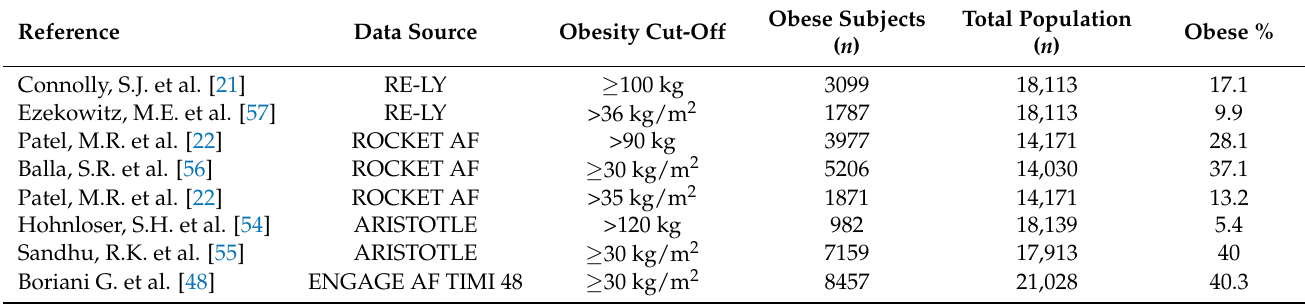
Legend. DOACs: direct oral anticoagulants. RE-LY indicates Randomized Evaluation of Long-Term Anticoagulation Therapy; ROCKET AF, Rivaroxaban Once Daily Oral Direct Factor Xa Inhibition Compared with Vitamin K Antagonism for Prevention of Stroke and Embolism Trial in Atrial Fibrillation; ARISTOTLE, Apixaban for Reduction in Stroke and Other Thromboembolic Events in Atrial Fibrillation; ENGAGE AF TIMI 48, Effective Anticoagulation with Factor Xa Next Generation in Atrial Fibrillation–Thrombolysis in Myocardial Infarction